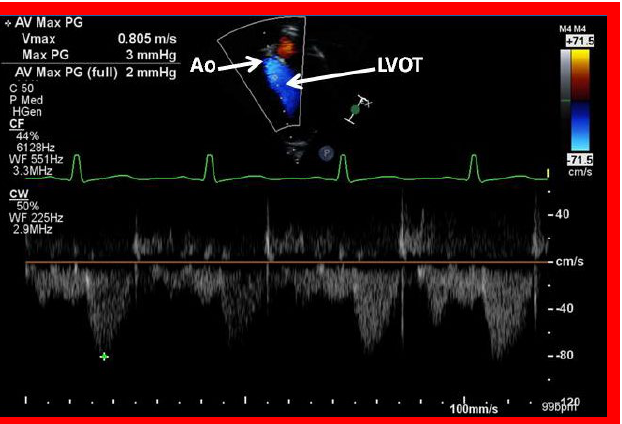
Figure 42. Selected video frames from an apical view demonstrating laminar flow from the left ventricle into the aorta (Ao). Note laminar flow in the LV outflow tract (LVOT) and low Doppler flow velocity (~0.8 m/s).